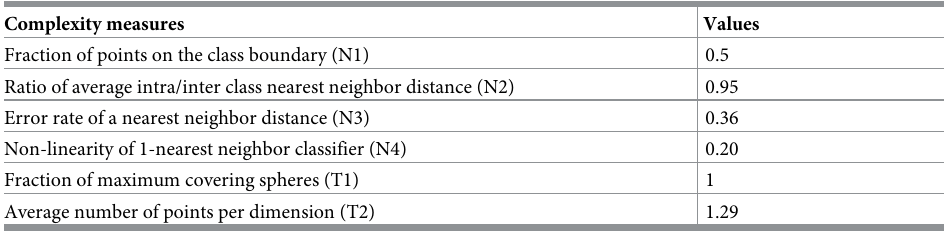
Table 4. Global complexity metrics of 3D knee